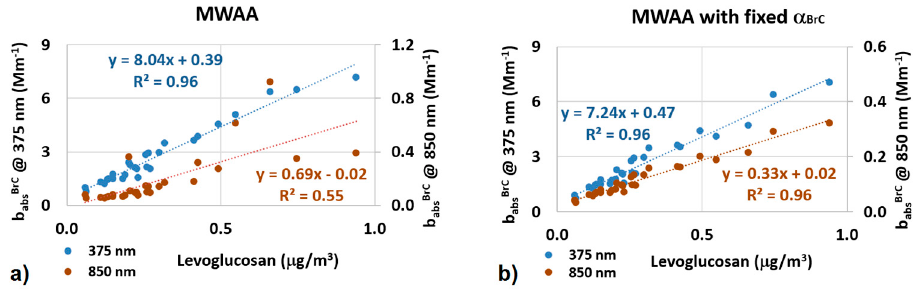
Figure 4. Scatterplot of b absBrC (375 nm) and b absBrC (850 nm) vs. levoglucosan concentration obtained in Propata running: ( a ) the original MWAA model, ( b ) MWAA model with fixed α BrC. Total carbon (TC) absolute concentration in the Propata dataset was 1.7 ± 0.7 µ g/m 3 Levoglucosan average concentration in Propata was 0.3 ± 0.2 µ g/m 3